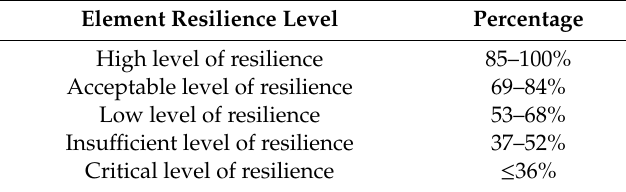
Table 3. Comparative table for the assessment of the element’s resilience level (Rehak et al. 2019).